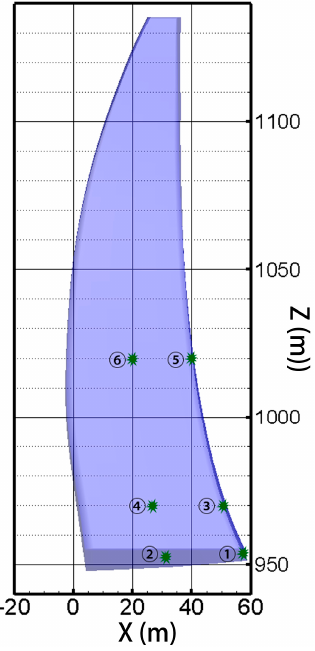
Figure 15. The position distribution of typical points.